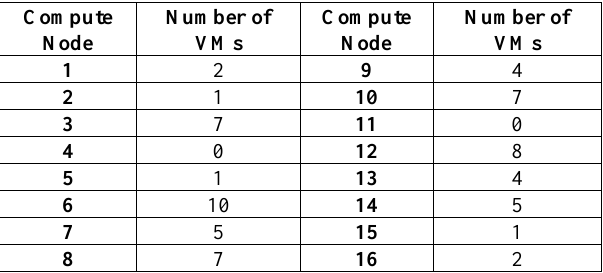
Table 2. Virtual machine allocation by